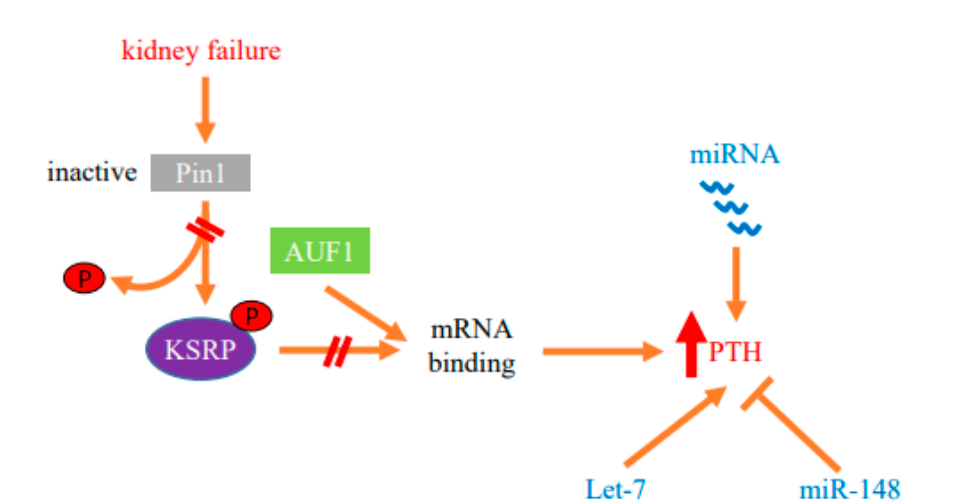
Figure 2. Protein–mRNA interactions and miRNA determine the post ‐ transcriptional increase in parathyroid hormone ( PTH ) gene expression in SHP. Decreased activity of the isomerase Pin1 in the parathyroid in SHP modifies protein–PTH mRNA interactions to increase PTH mRNA stability and levels in experimental chronic kidney failure. The stimulation of PTH expression is also dependent upon miRNA. Parathyroid miRNAs are dysregulated in both chronic kidney disease patients and experimental models. Mice with parathyroid specific knockout of Dicer, which prevents global miRNA maturation and function, fail to increase serum PTH after acute and chronic hypocalcemia or uremia, demonstrating that miRNAs are essential for parathyroid stimulation in SHP. Let ‐ 7 and miR ‐ 148 miRNA families that are dysregulated in CKD ‐ SHP modify PTH secretion in vivo and in vitro, suggesting roles for these miRNAs in the increased PTH expression.